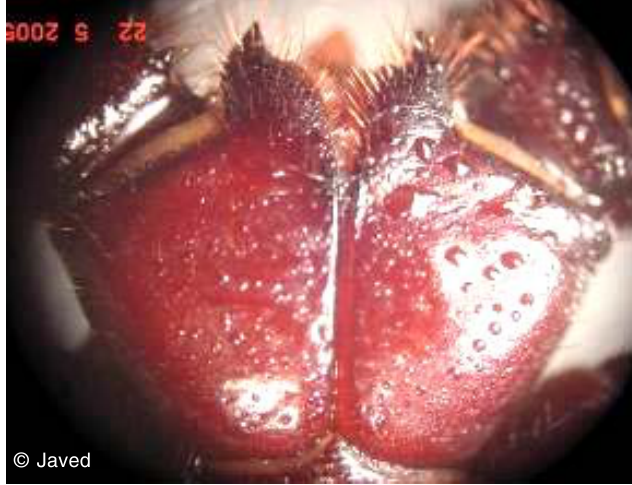
© Javed Image 5. Ventral view of pedipalp coxa showing maxillary process with tooth.